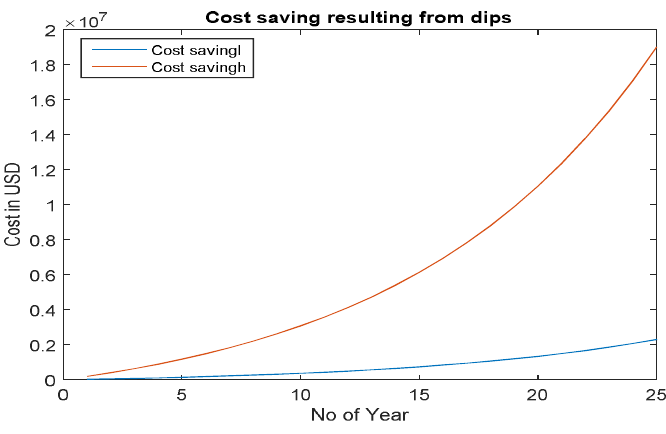
Figure 12. Cost saving scenario’s resulting from dips.